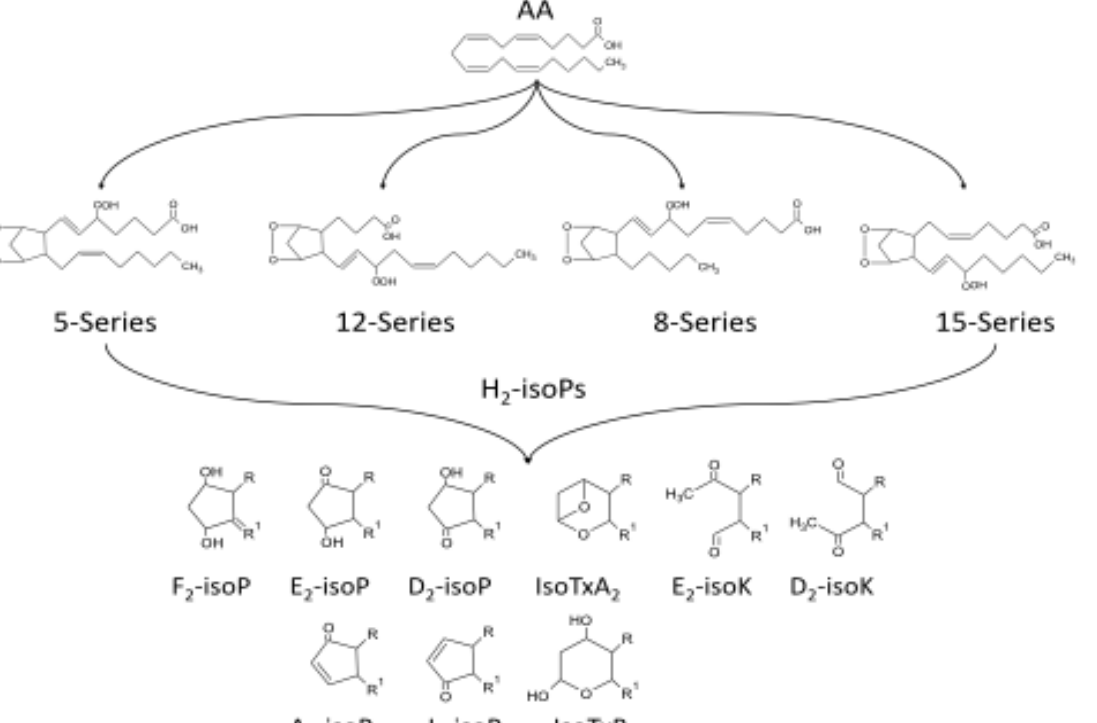
Figure 4. Concentration of 8-isoPGF